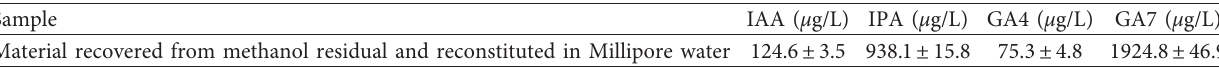
Table 4: Summary of endogenous phytohormones analyzed in crude methanol extract of C. sorokiniana TH01 grown outdoor in raceway pond ( n � 3, p < 0 . 05).